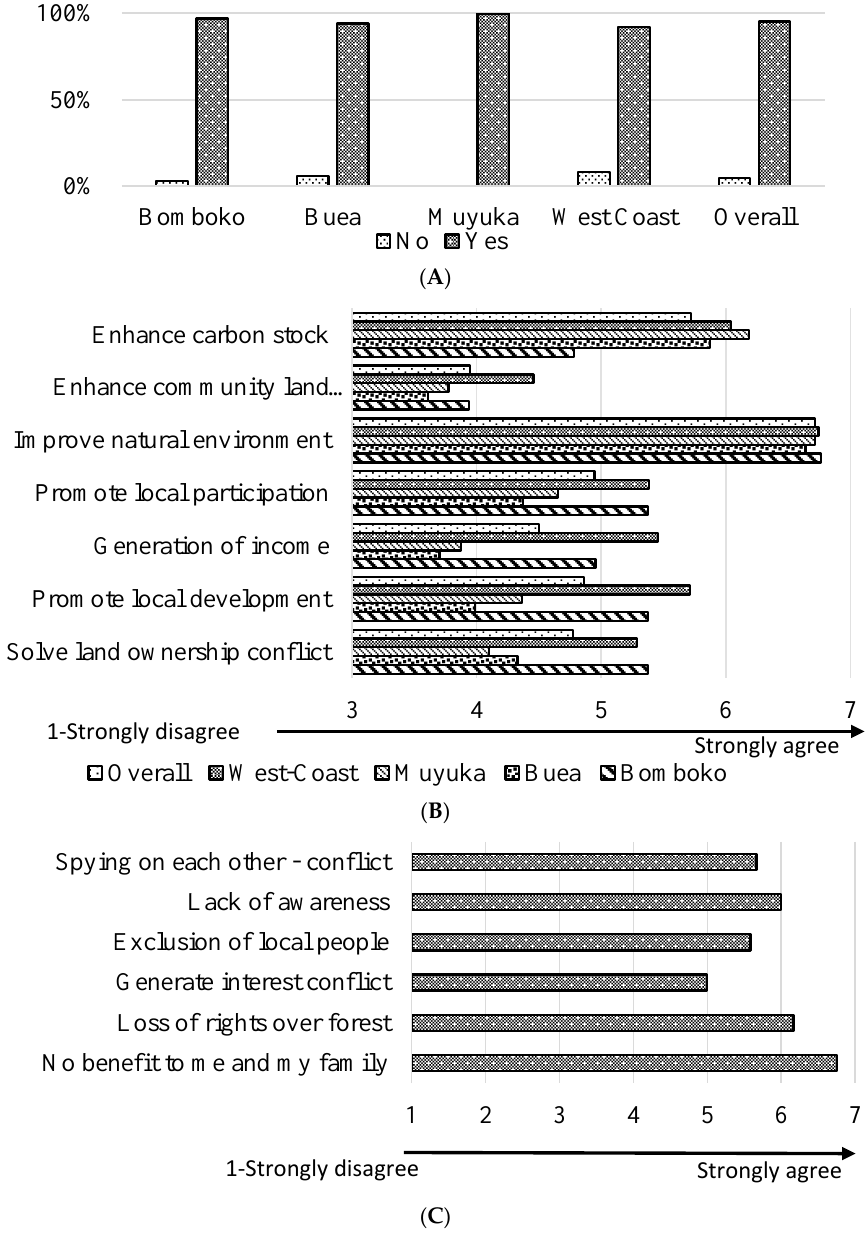
Figure 6. Percentages of respondents supporting MCNP initiative ( A ) and reasons for supporting ( B ) or not supporting ( C ) MCNP conservation initiative.